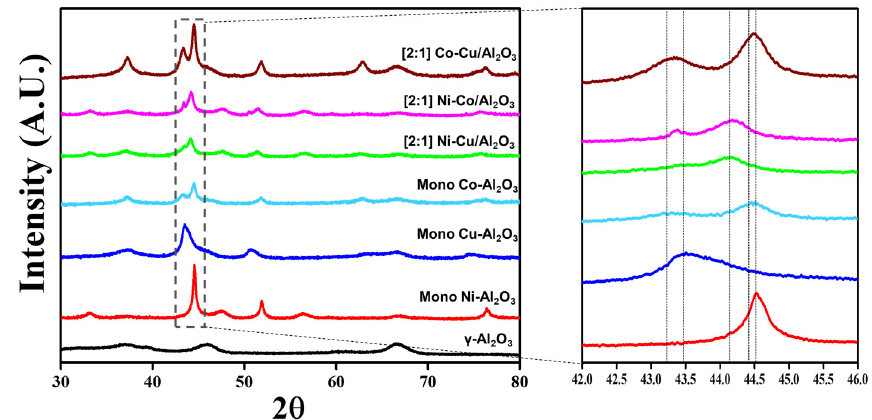
Figure 2. XRD patterns of the reduced monometallic and bimetallic catalysts.